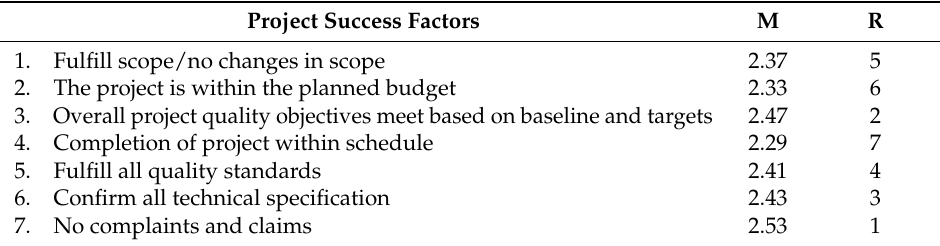
Table 6. Ranking of Project Success Factors.